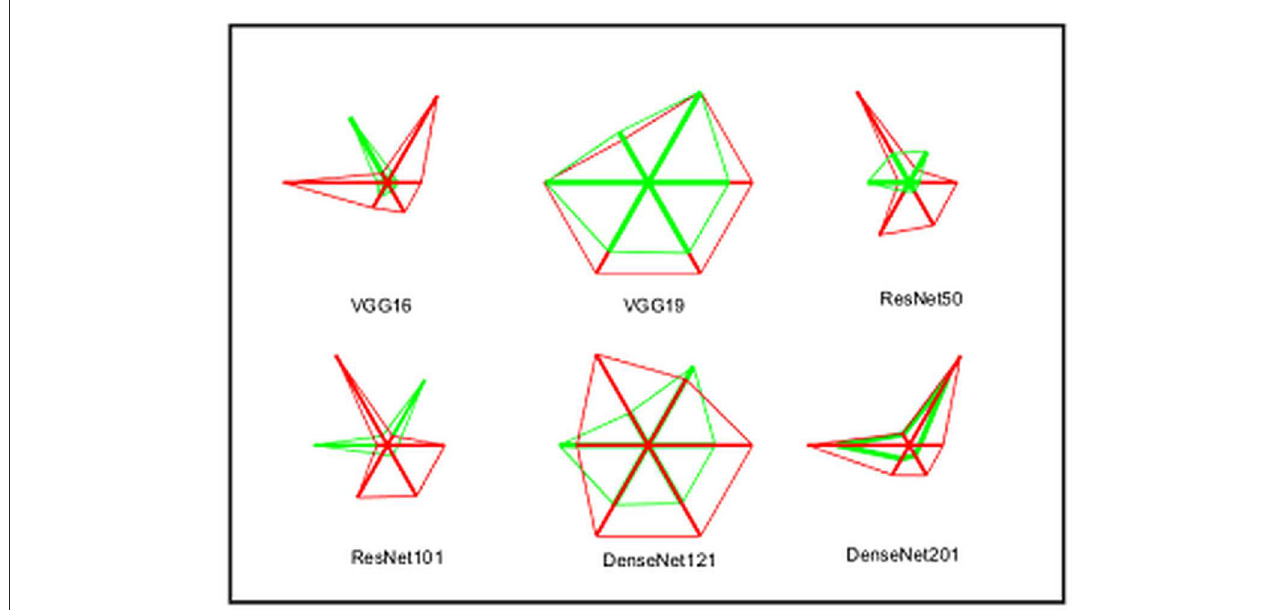
FIGURE4 Integrated Glyph plot to demonstrate the overall performance of the considered methods.